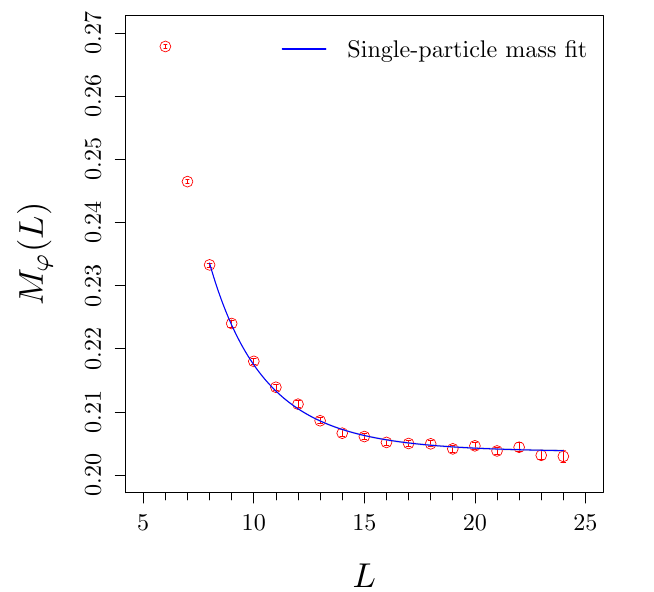
Figure 6. Volume dependence of the single-particle mass. The lattices with temporal extension T = 48 are considered. The blue curve corresponds to the fit in the range [8,24] for L